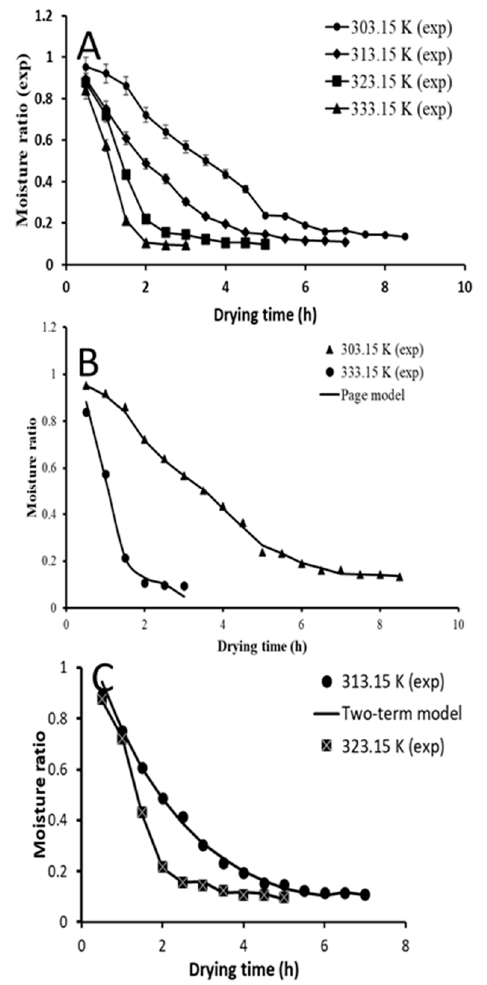
Figure 2. Relationship between moisture ratio (experimental) vs. drying time of Kyoho skin ( A ), Page model at 303.15 K and 333.15 K ( B ), and ( C ) two ‐ term model at 313.15 K and 323.15 K. Error bar represents the standard deviation of the mean.